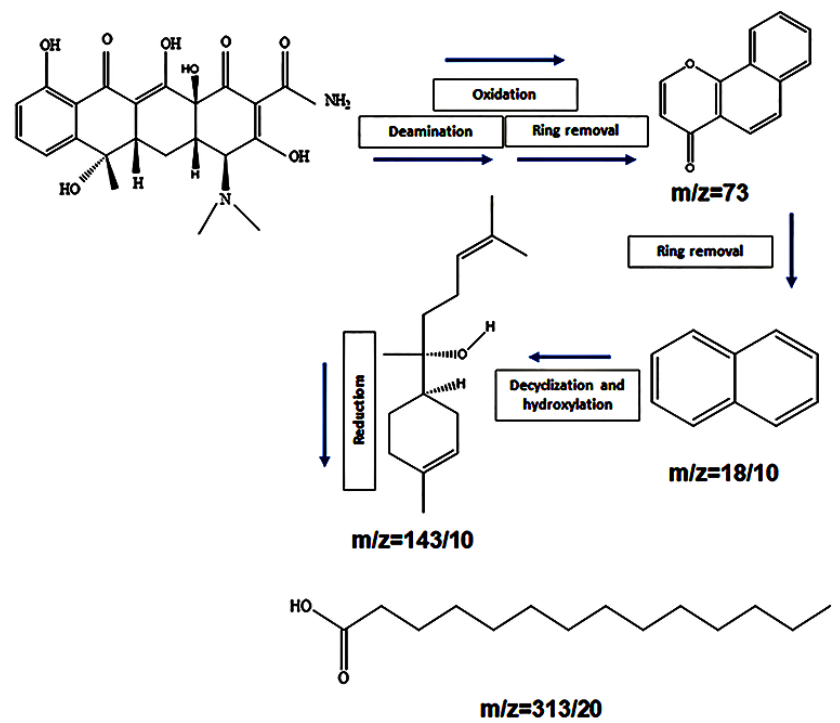
Figure 8. The proposed pathway for degradation of TC in the presence of the magnetite/Gd 3+ / β - cyclodextrin nanoplatform.